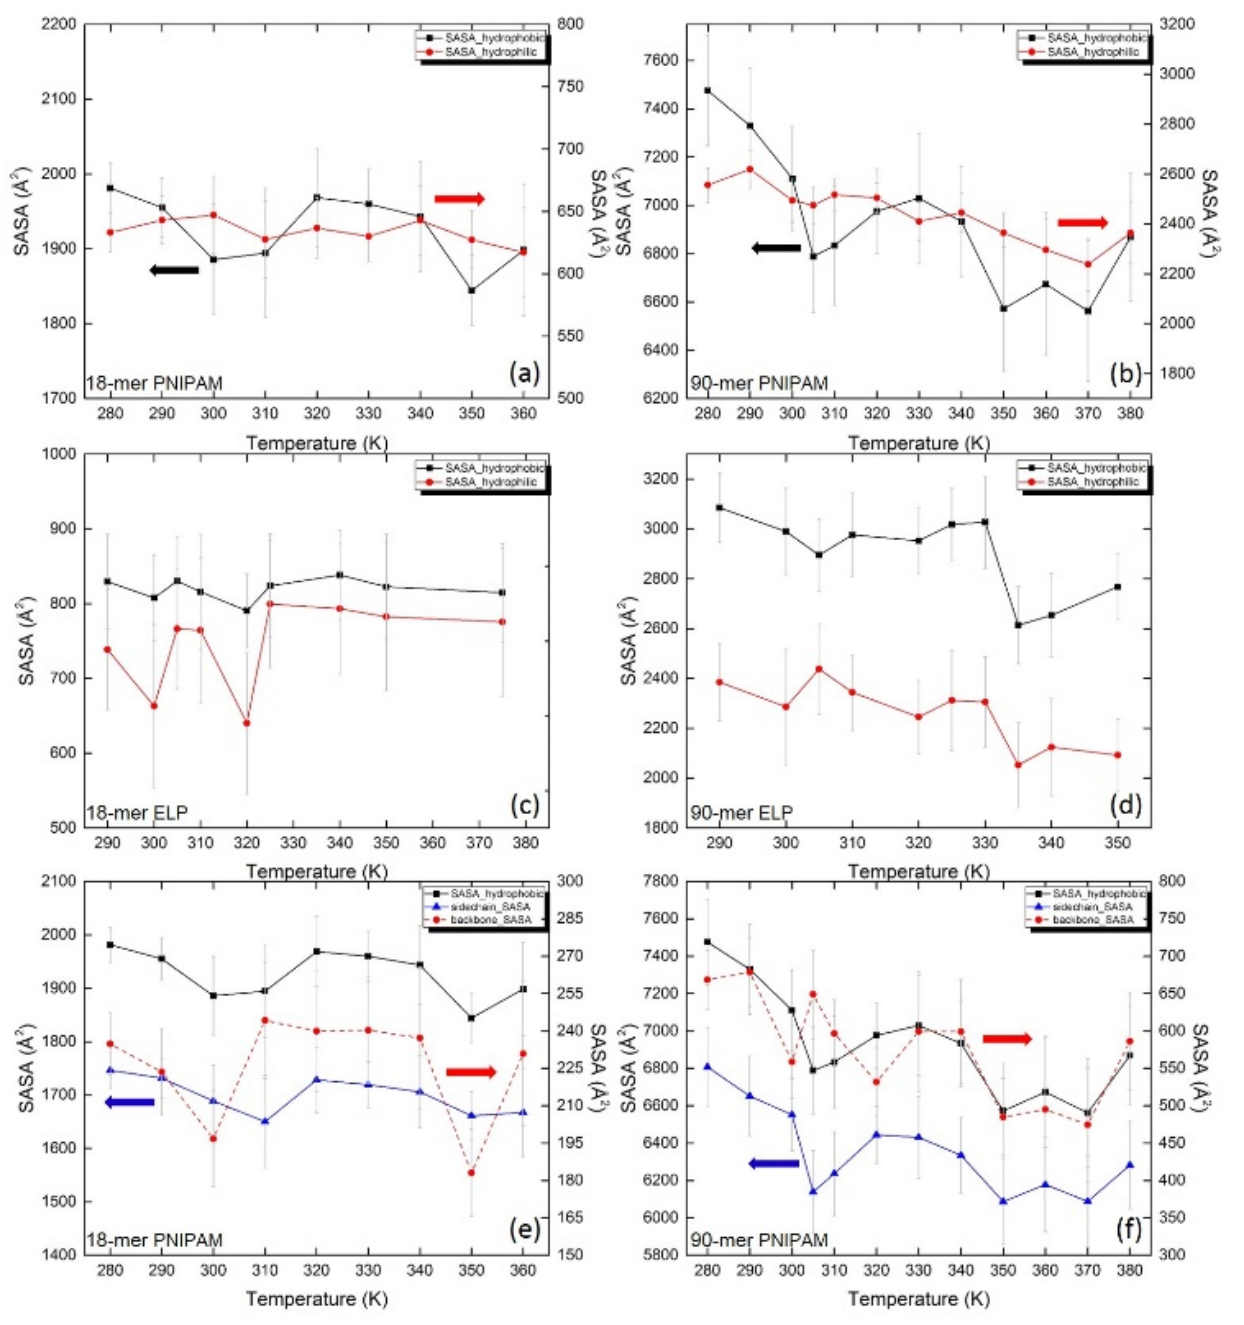
Figure 6. Solvent accessible surface area (SASA) for hydrophilic groups (red) and hydrophobic groups (black) at different temperatures of PNIPAM ( a ) 18-mer and ( b ) 90-mer and of ELP ( c ) 18-mer (GVG(VPGVG) 3 ) and ( d ) 90-mer ((VPGVG) 18 ). Contribution of SASA of hydrophobic groups of PNIPAM ( e ) 18-mer and ( f ) 90-mer, with (black) overall SASA of hydrophobic groups, (red dash) SASA of backbone, and (blue) SASA from isopropyl moieties in the side chain. Since hydrophilic groups of PNIPAM do not substantially contribute to the change in SASA with temperature, we next examine the contributions of hydrophobic groups